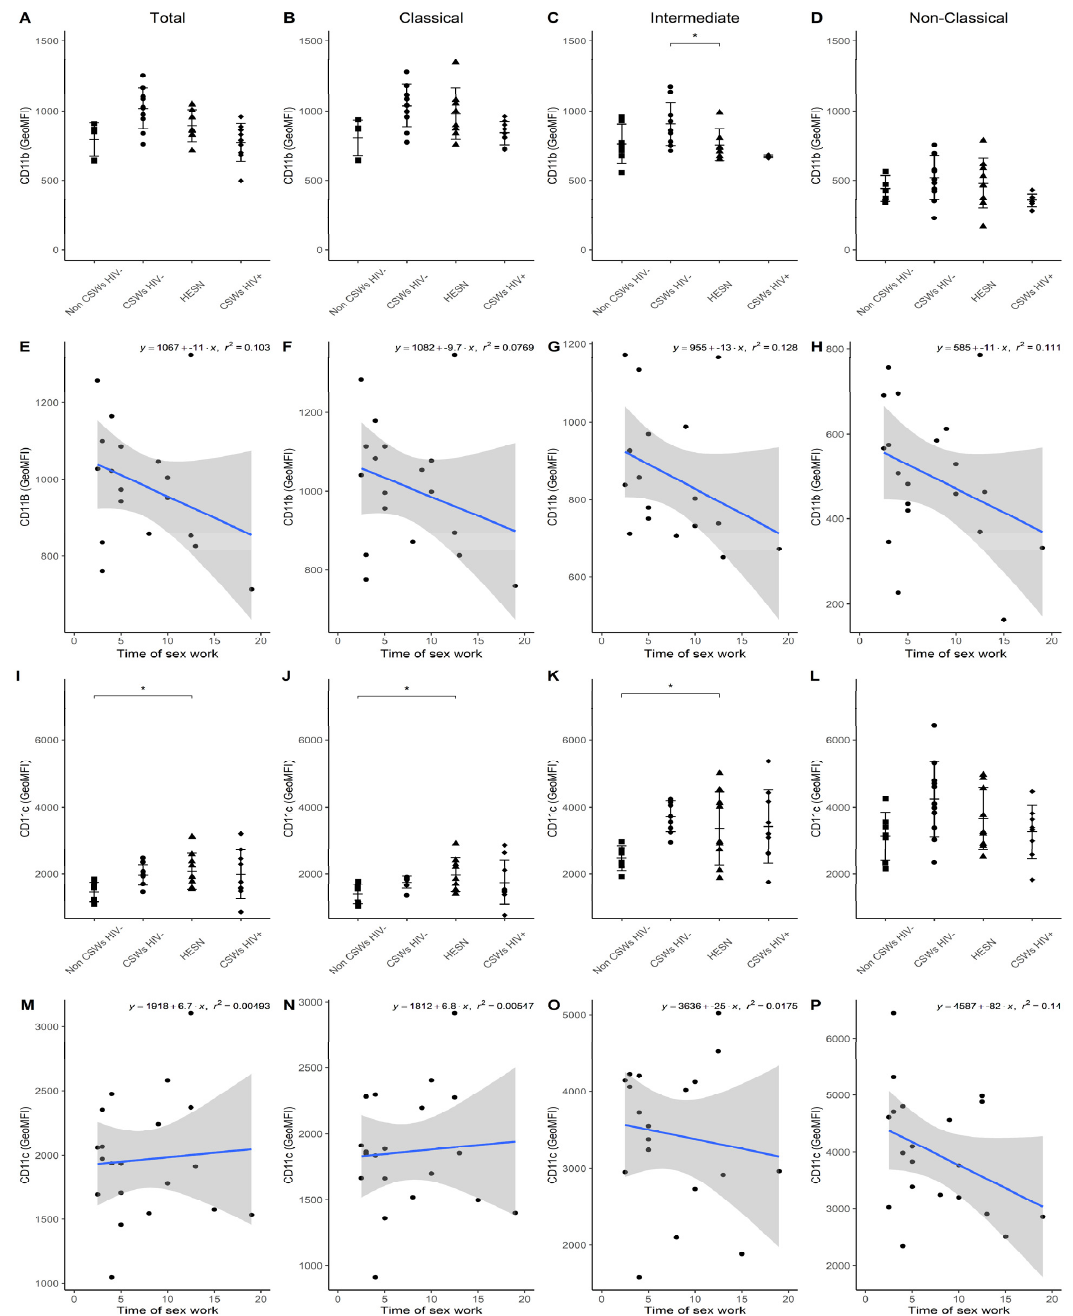
Figure 4. Flow cytometry analyses of CD11b and CD11c expression levels by live blood monocyte populations. ( A – D ) Levels of expression of CD11b and ( I – L ) CD11c proteins, as determined by geometric mean fluorescence intensity (GeoMFI), by ( A , I ) CD14 + total, ( B , J ) CD14 + CD16 - classical, ( C , K ) CD14 + CD16 + intermediate, and ( D , L ) CD14 low/dim CD16 ++ non-classical monocytes. Data are presented as the mean value ± SD of samples from 7 non-CSWs HIV- (HIV-1-uninfected control women from the general population), 9 CSWs HIV- (HIV-1-uninfected 2.5–5-year CSWs “early HESNs”), 11 HESNs (HIV-1-uninfected ≥ 10 years CSWs), and 9 CSWs HIV+ (HIV-1- infected CSWs). Significance levels are shown as * ( p < 0.05). ( E – H , M – P ) Linear regression anal- yses are shown for CSWs HIV- (HIV-1-uninfected 2.5–5-year CSWs “early HESNs”) and HESNs (HIV-1-uninfected ≥ 10 years